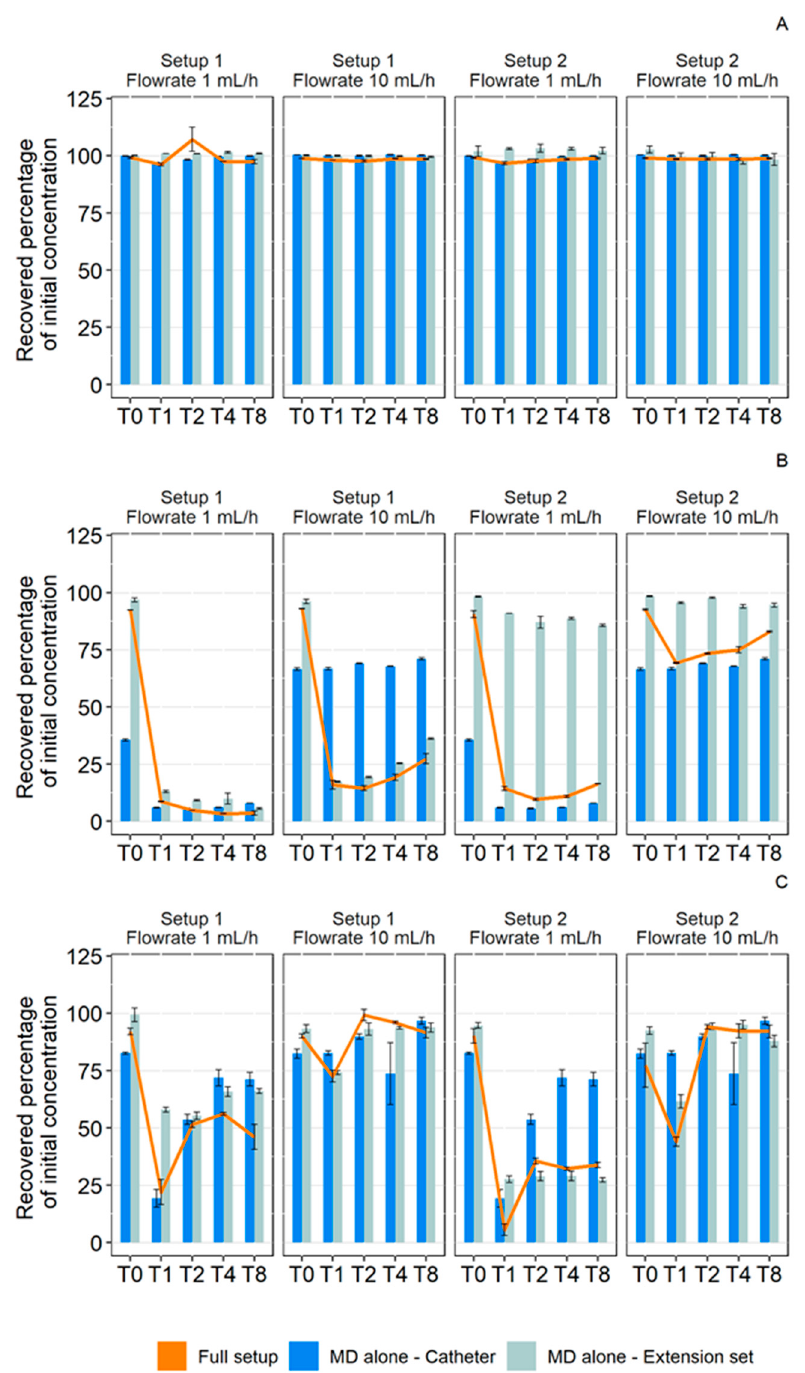
Figure 8. Comparison of the recovered percentage of initial concentration in paracetamol ( A ), diazepam ( B ), and insulin ( C ) during 1 mL/h and 10 mL/h dynamic contact with medical devices (MD) alone (blue: catheter; gray: extension set) and with a complete setup (orange). (Setup 1: polypropylene syringe + polyvinyl chloride extension set + Turbo-Flo polyurethane catheter. Setup 2: polypropylene syringe + polyethylene coextruded with polyvinyl chloride extension set + Turbo-Flo polyurethane catheter ( n = 3, mean ± standard error of the mean). T0–T8: different analysis times: immediately after purging (T0), then after 1 h (T1), 2 h (T2), 4 h (T4), and 8 h (T8) of infusion.